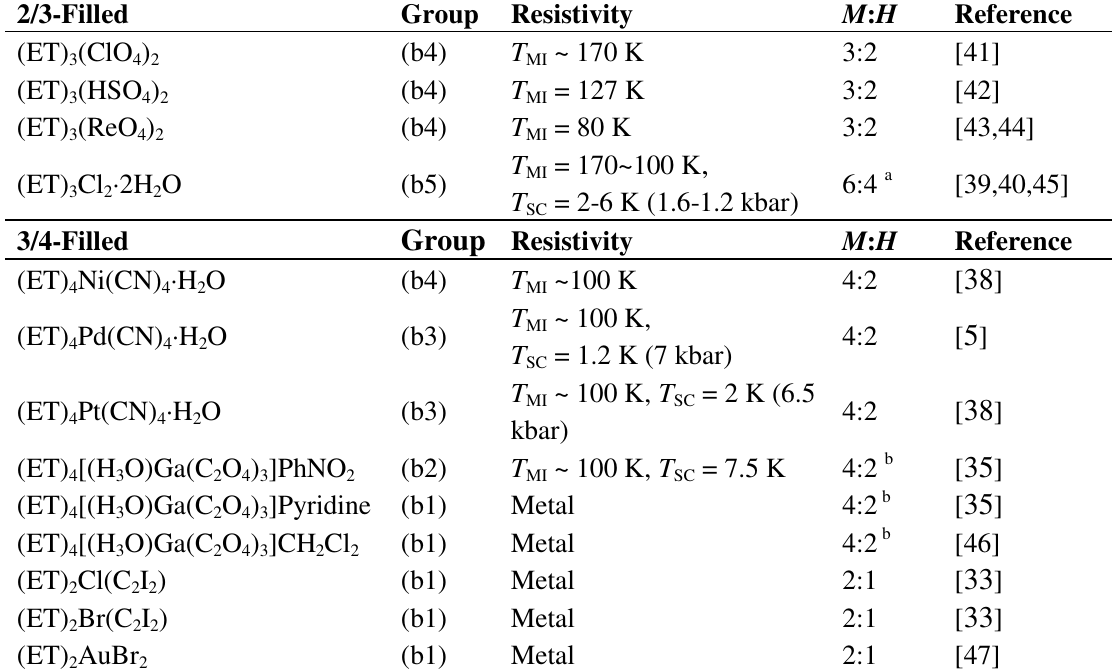
Table 1. List of the β ″ -type ET salts discussed in the present review. The results of temperature dependence of the electrical resistivity are shown in the second column. “ M : H ” denotes the ratio between molecules and holes in the repeat unit in the 2D layer. The right column denotes the references where the crystal structures or electrical resistivity are reported.